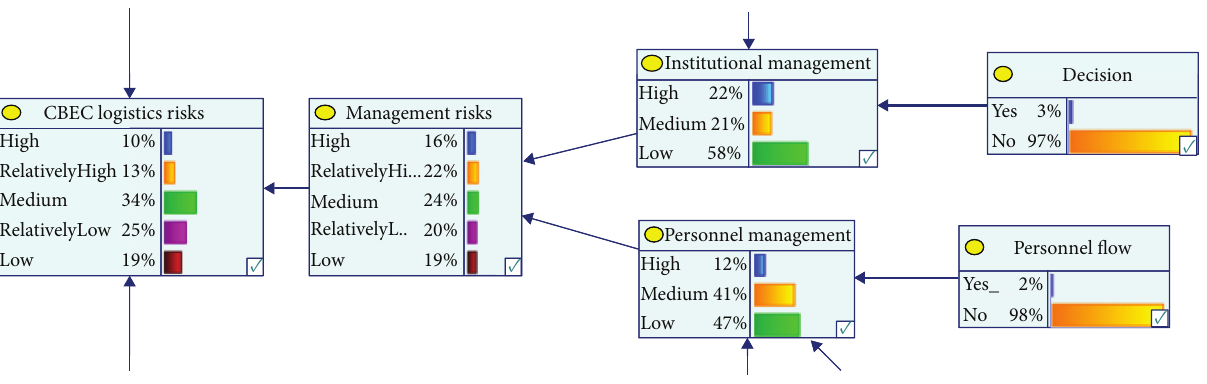
Figure 6: Before dismissal.